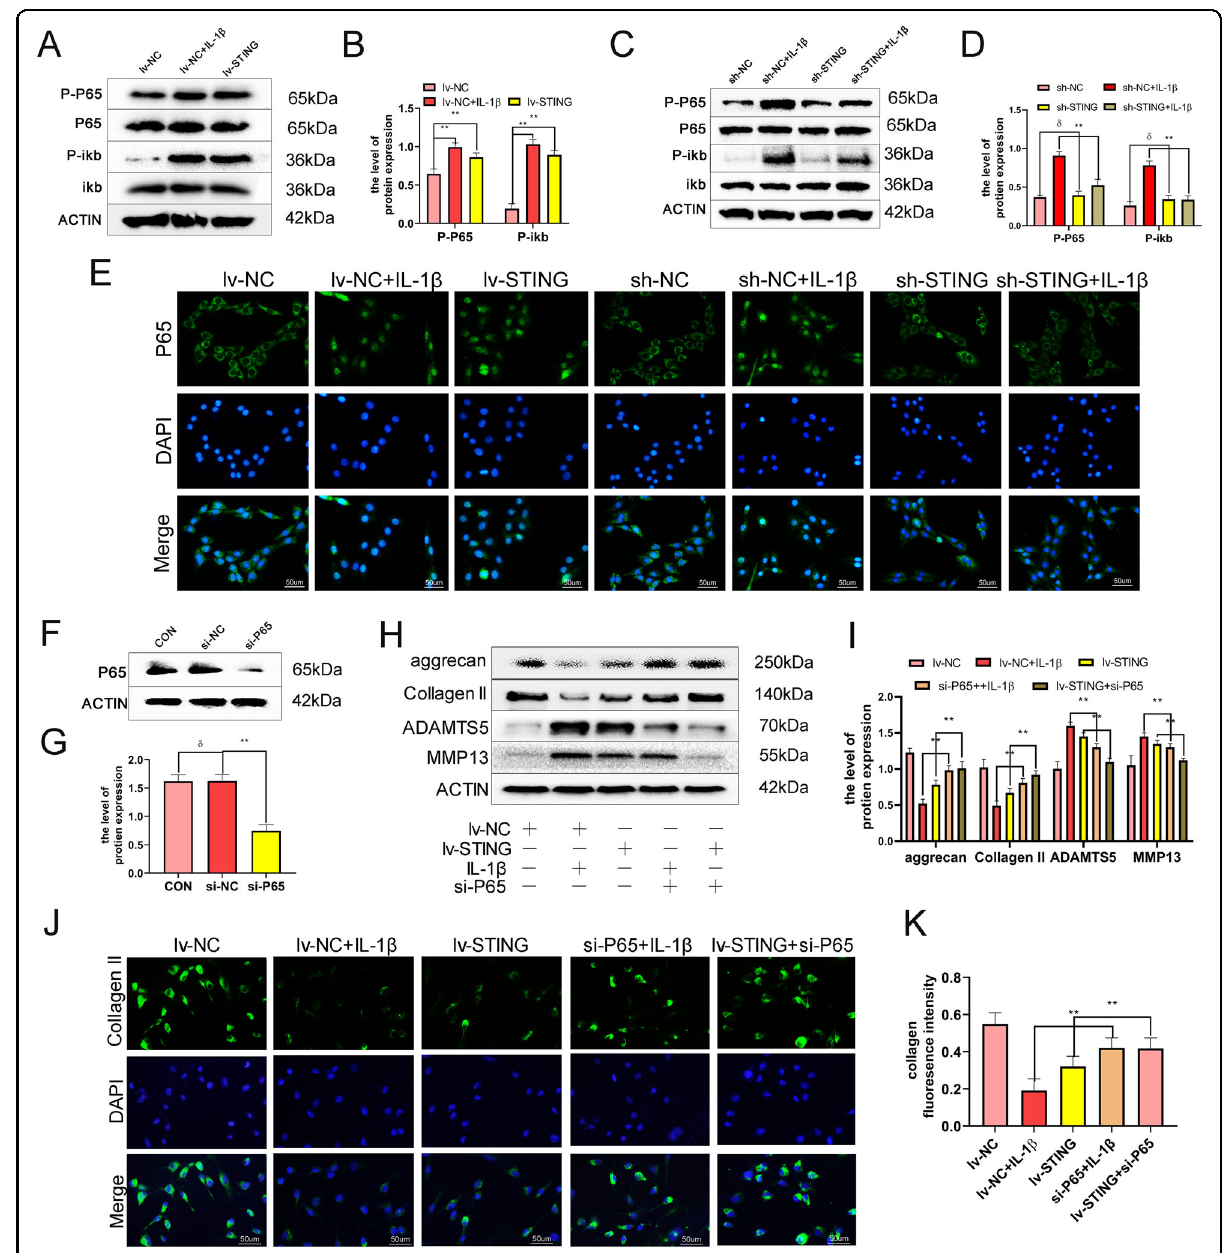
Fig. 4 STING induces ECM degradation via NF- κ B activation. The mouse chondrocytes were pre-exposed to lv-STING or sh-STING or si-P65 followed by exposure to IL-1 β (10 ng/ml) for 24 h. A – B Western blot as well as its quanti fi cation revealed the phosphorylation level of P65 and i κ b after exposure to IL-1 β or lv-STING. C – D Western blot along with its quanti fi cation revealed the phosphorylation level P65, as well as i κ b after exposure to IL-1 β or sh-STING. E Immuno fl uorescence staining of P65 in chondrocytes (bar: 50 μ m). F – G Western blot along with its quanti fi cation revealed that the siRNA-mediated P65 knockdown was successful. H – I Western blot along with its quanti fi cation revealed that the level of Collagen II, Aggrecan, MMP13, and ADAMTS5 as treated above. J – K Immuno fl uorescence staining of collagen II in chondrocytes as treated above (bar:50 μ m). All data were presented as mean ± SD ( n = 5); ** P <